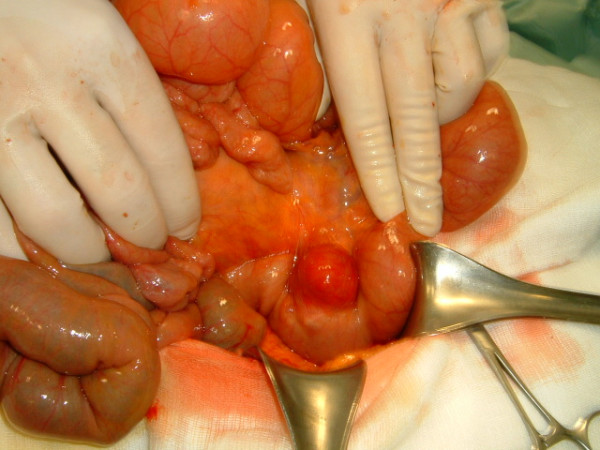
Operative view: esophytic GIST of the fourth duodenal portion.